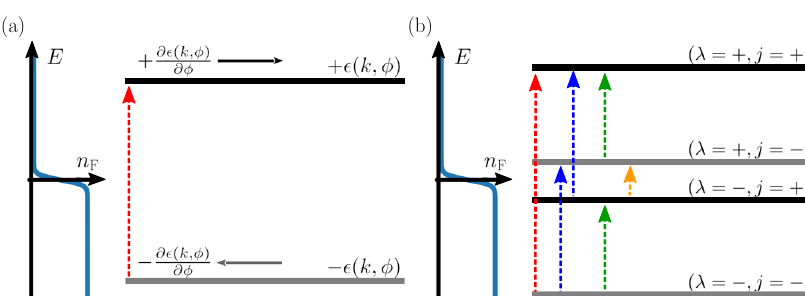
Fig. 2 Scheme of the subgap levels for a generic y -component of the wavevector k , and superconductive phase difference ϕ . a The clean limit ( γ → ∞ ), where the effect of the impurities vanishes. Gray (black) level represent the lower (upper) Andreev bound state (ABS), the gray (black) horizontal arrow sketches the direction of the supercurrent contribution ∝ − ∂ ϵ ( k , ϕ )/ ∂ ϕ ( ∝ ∂ ϵ ( k , ϕ )/ ∂ ϕ ), and the red vertical dashed arrow denotes the possible transition. On the left side, there is the Fermi-Dirac distribution at low temperature, k B T ≪ Δ 0 , which shows that lower (upper) ABS is occupied (empty). b The limit γ → 0 + . Gray (black) levels Ω λ Ω λ fi nite overlap on the lower (upper) ABSs of the clean graphene Josephson , − ( , + ) are associated to states which have a Junction (GJJ), and zero overlap on the upper (lower) ABSs of the clean GJJ. The colored vertical arrows represent the possible transitions between two subgap levels, arrows represented with the same color correspond to the same transition energy. On the left side, there is the Fermi-Dirac distribution at low temperature, by comparing this with the vertical transitions, one can infer that the transitions between ABSs labeled with opposite j indices and identical λ indices (green dashed lines) are suppressed by the Pauli blocking.